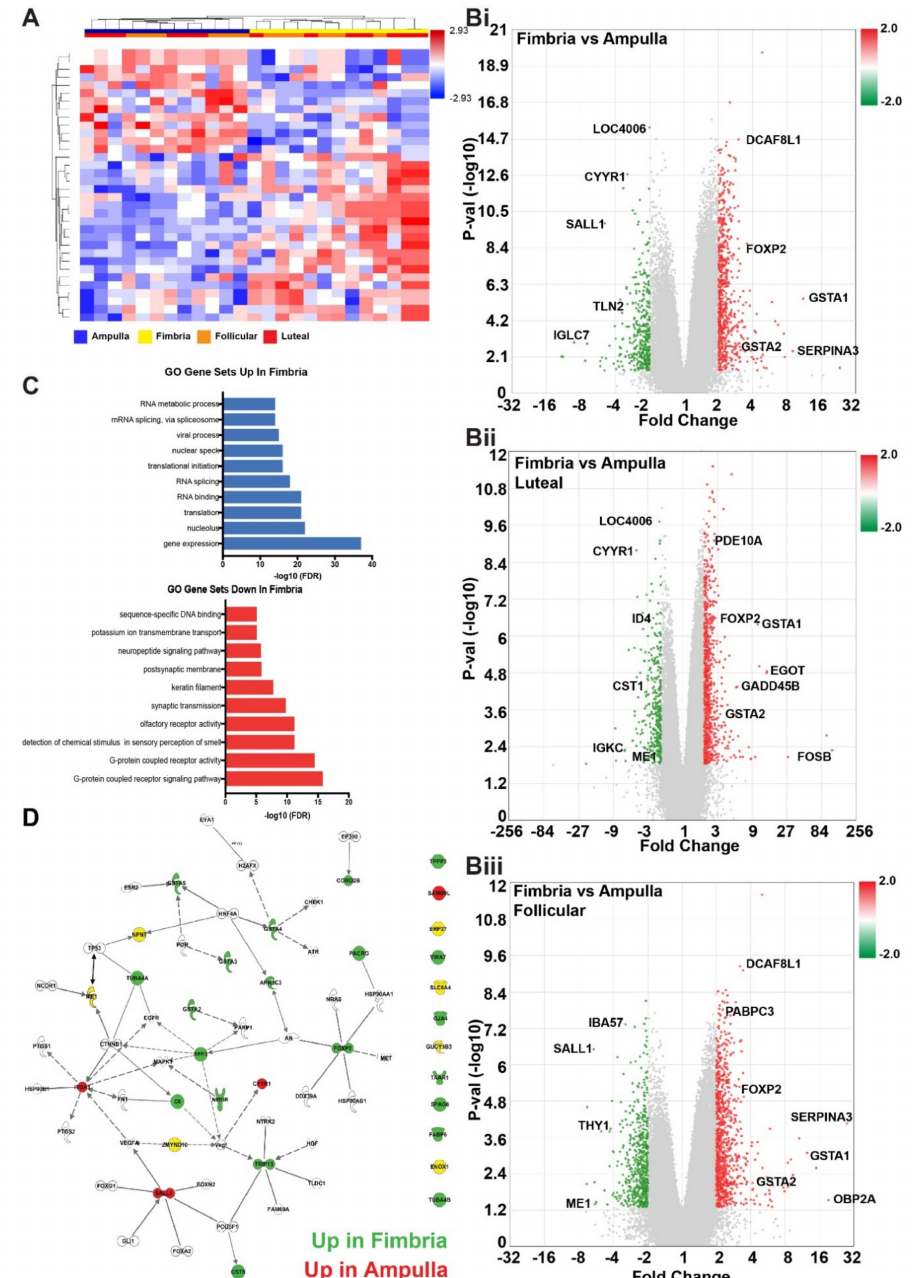
Figure 3. Gene expression analysis identifying di ff erences in gene ontology pathway representation and gene upregulation and downregulation between fimbria and ampulla. ( A ) Heat map of supervised hierarchical clustering revealed significant di ff erences (2-fold change, p < 0.05) in gene expression between ampulla and fimbria. As seen previously, some follicular and luteal phase genes segregate by fimbria and ampulla of the normal FTE expression pattern. ( B ) Volcano plots showing a comparison of i : fimbria compared to ampulla, independent of ovulatory phase, ii : fimbria compared to ampulla in the luteal phase, iii : fimbria compared to ampulla in the follicular phase. ( C ) Top gene processes upregulated and downregulated in the fimbria compared to the ampulla as determined by gene ontology. ( D ) Gene network of top di ff erentially expressed genes by anatomy in the fallopian tube show genes up in the fimbria (green) and ampulla (red). Image was generated using Ingenuity Pathway Analysis